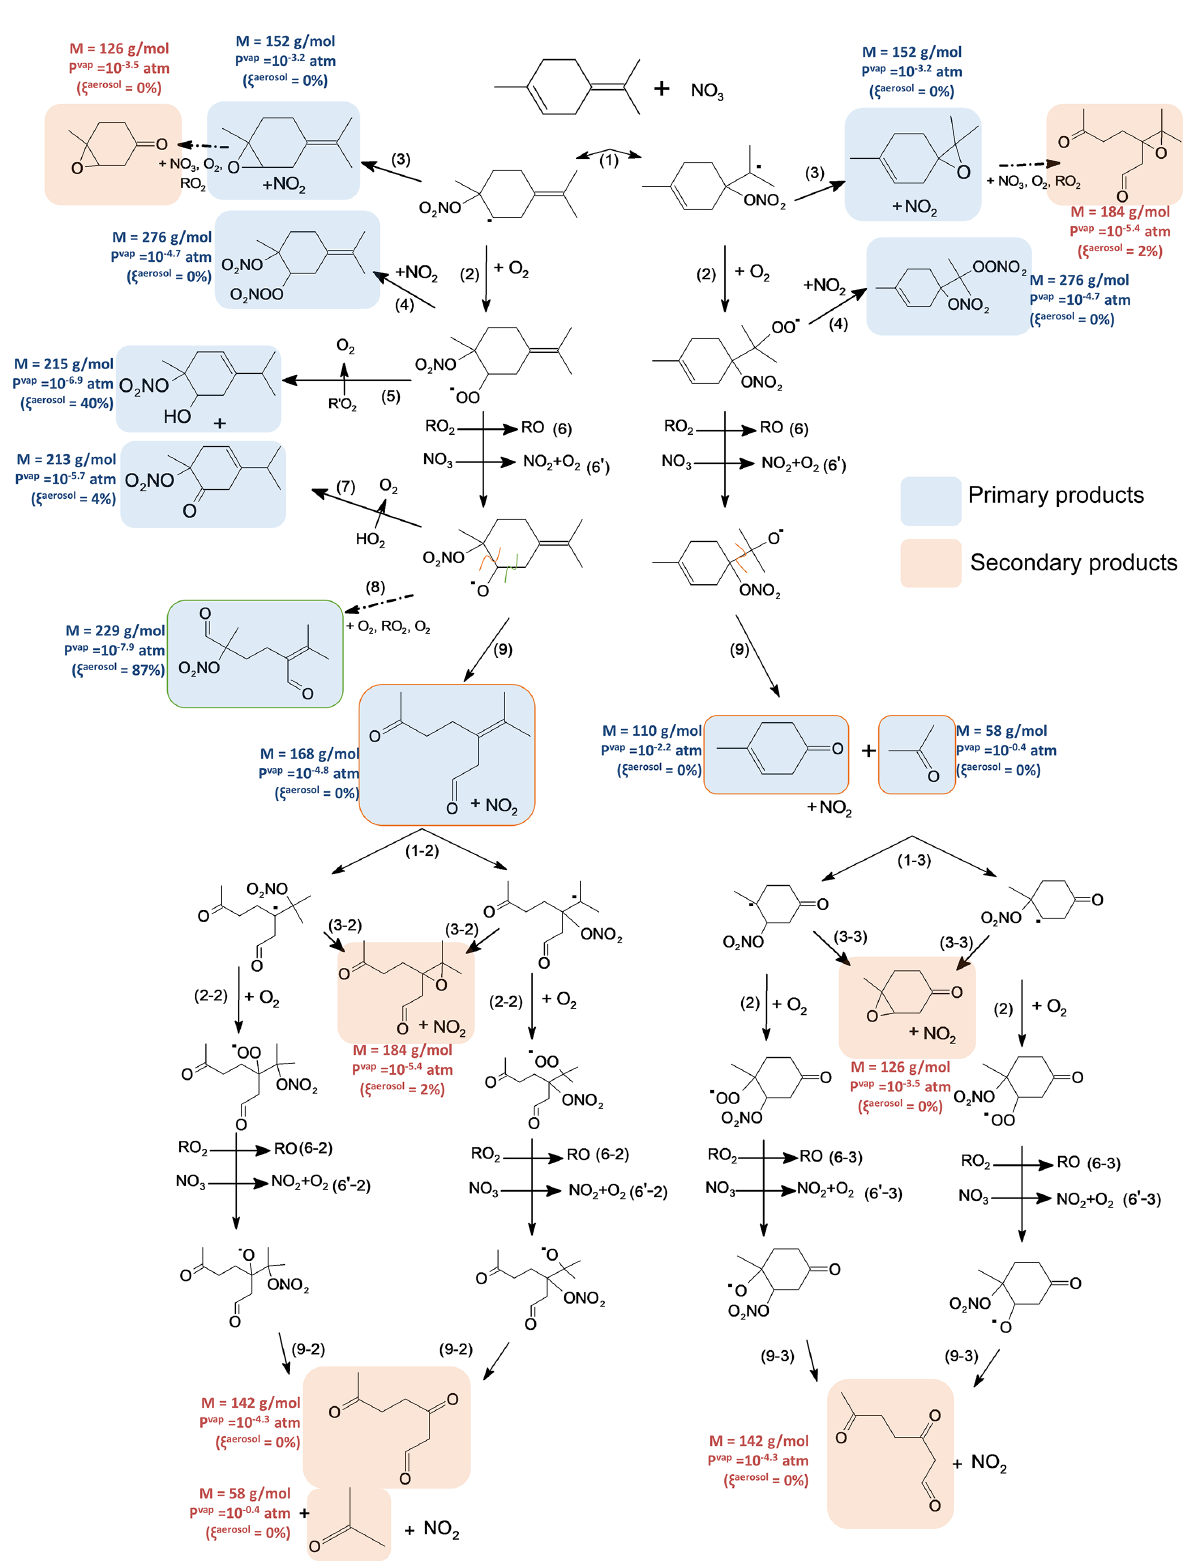
Figure 8. Proposed mechanism for terpinolene. First-generation products are squared in blue and second-generation ones in red. Alkoxy fragmentation products are squared according to the location of the fragmentation. Molecular weight, vapor pressures and the gas–particle partition are shown next to the